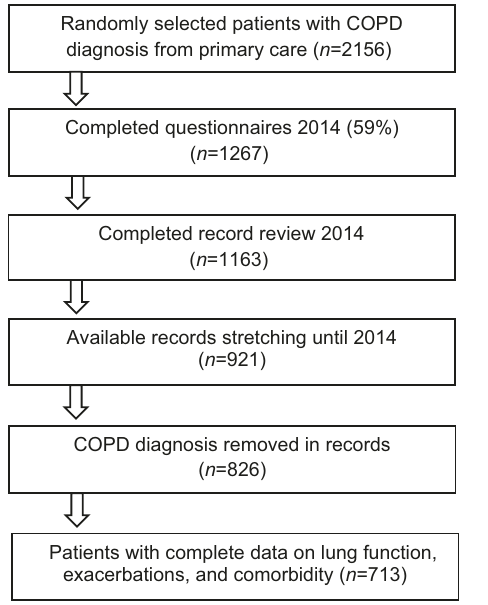
Fig. 1 Flow chart. Selection of patients eligible for inclusion in the